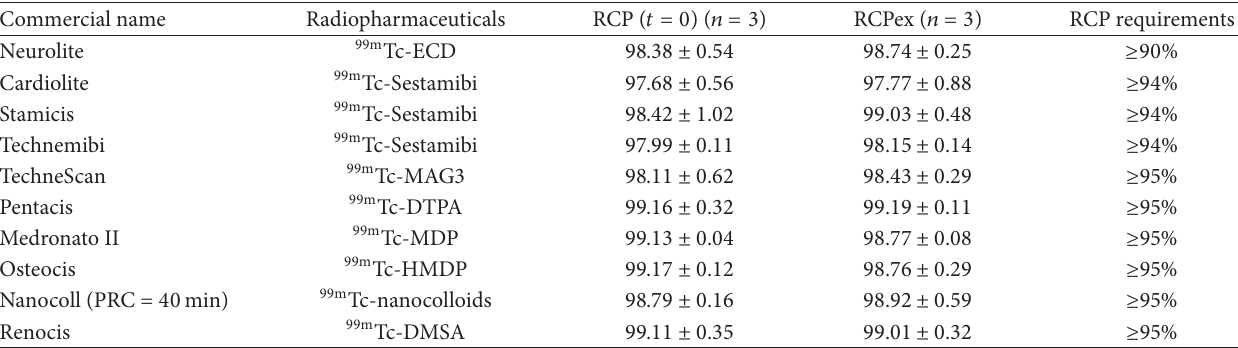
RCPex indicates the radiochemical purity at the end of the expired time. Table 6: RCP of radiopharmaceuticals at 𝑡 = 0 and at the expired time specified by the manufacturer, prepared with the first eluate obtained from Elumatic III (IBA) generator.